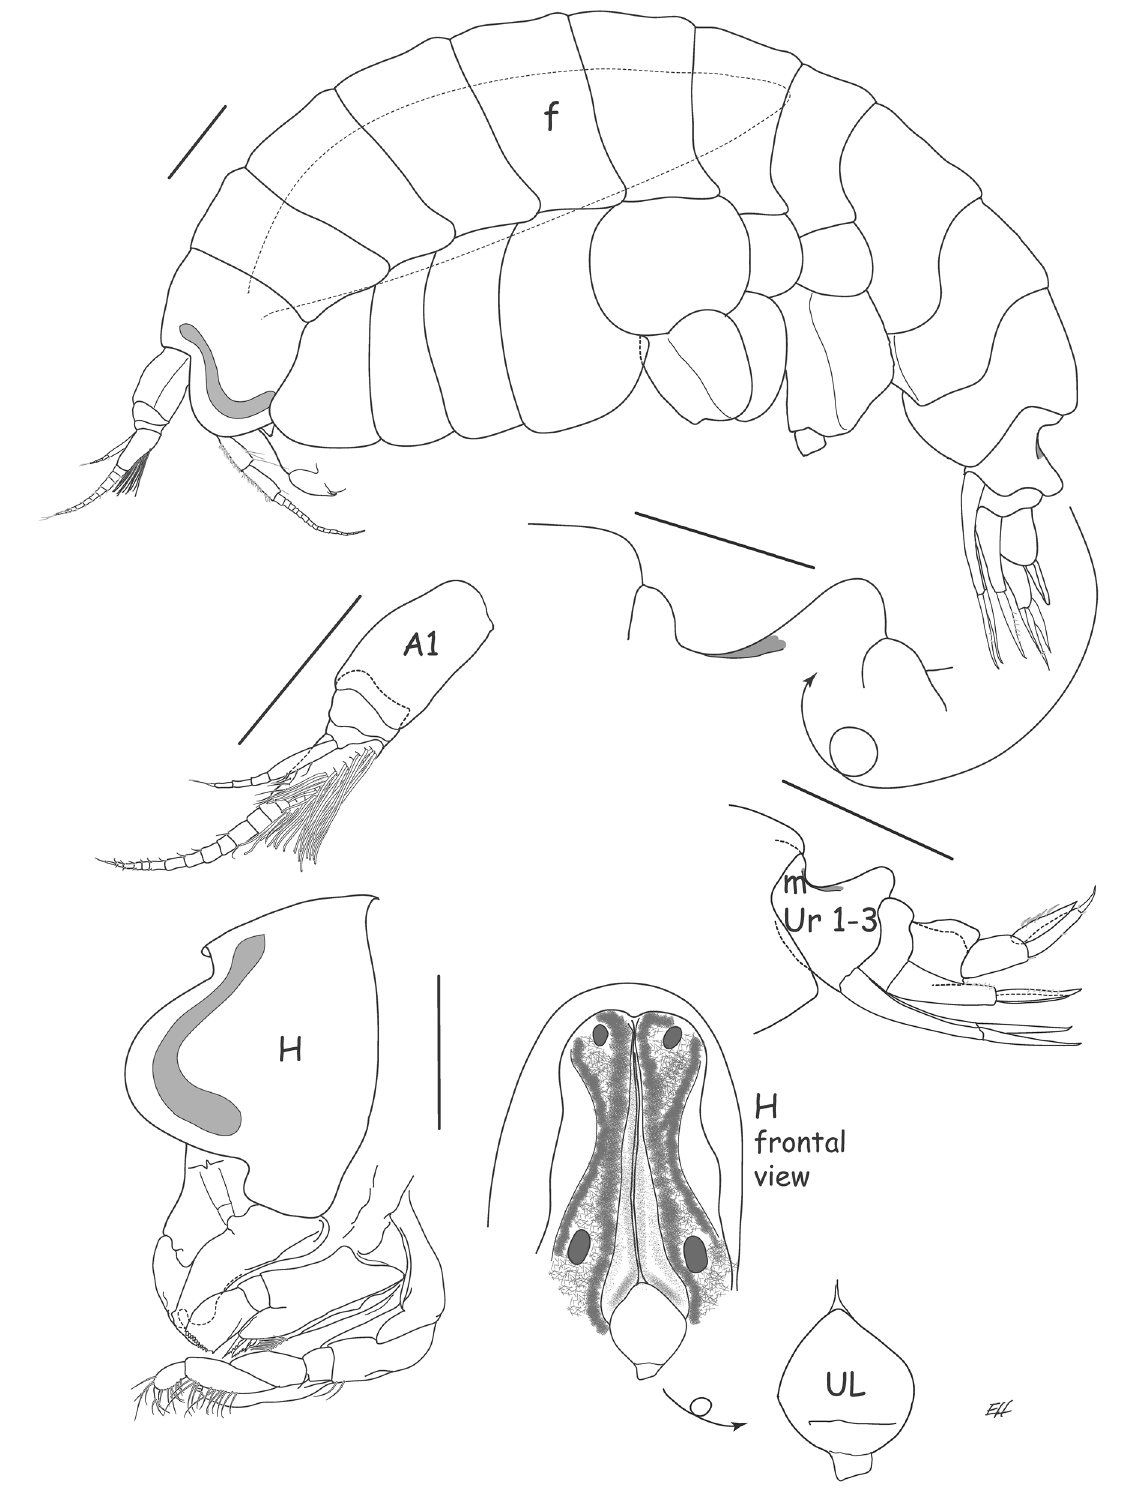
Fig. 26. Abyssorchomene shannonae sp. nov., holotype, ♀, 12 mm (ZMH K-61209); allotype, ♂, 7 mm (ZMH K-61210), RV Polarstern ANT XXII-3 (ANDEEP III), station PS67-78-1, eastern Weddell Sea, depth 2194 m., 21 February 2005. Dotted line on habitus shows approximate stomodeum position. Figures with sex not indicated are of female. Scale bars = 1